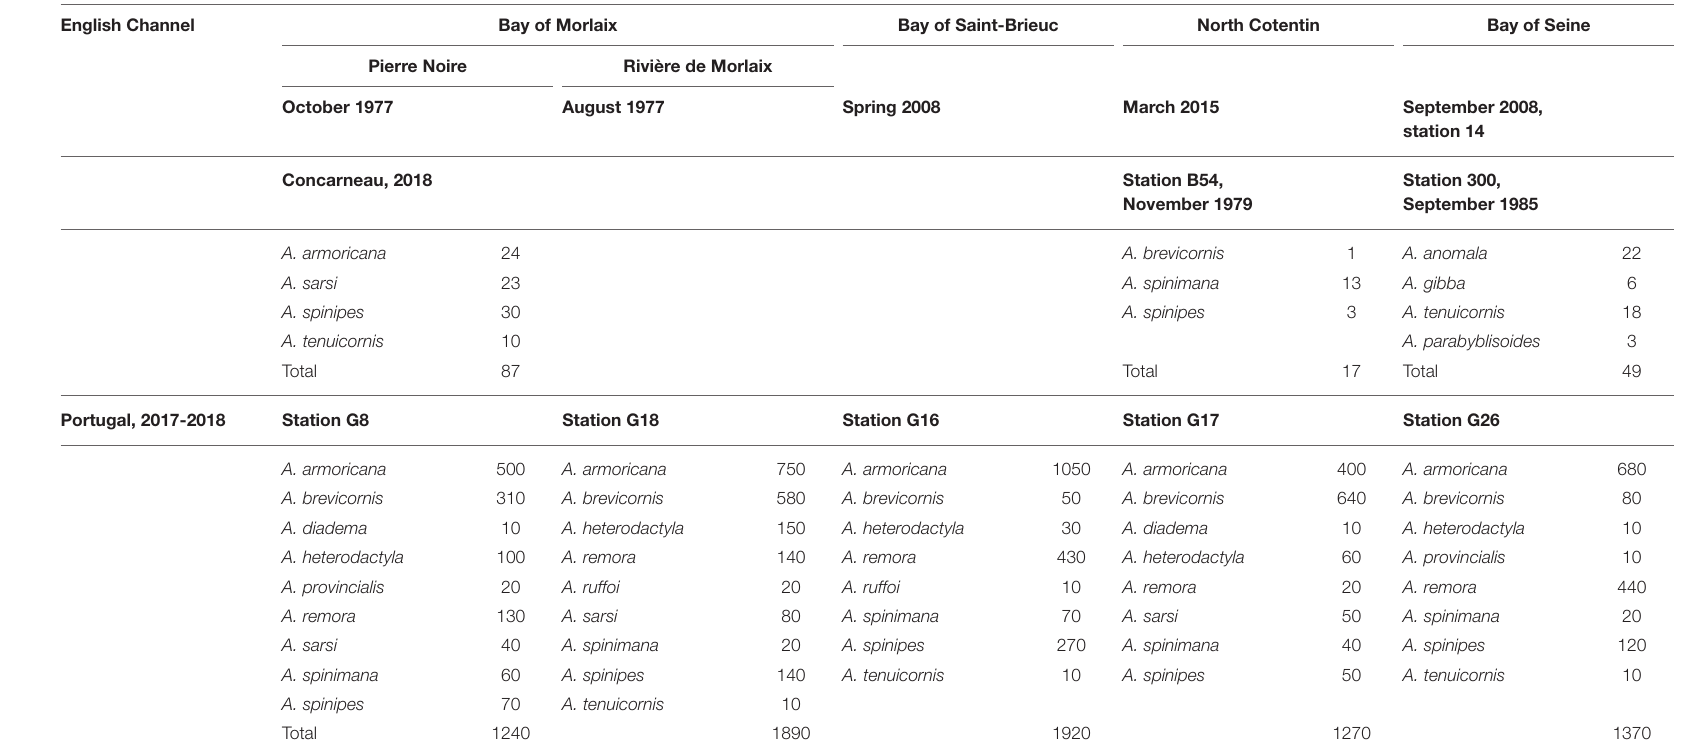
TABLE 3 | Continued English